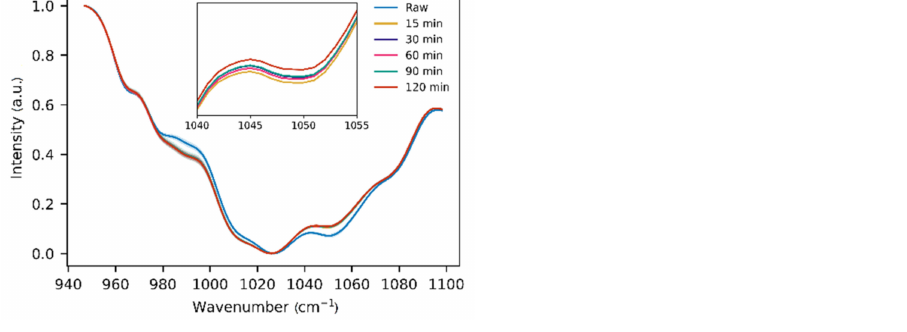
Figure 2. Fingerprint region of FTIR spectra of eucalyptus honey before and after thermal treatment at 70 ◦ C for 15, 30, 60, 90, and 120 min.